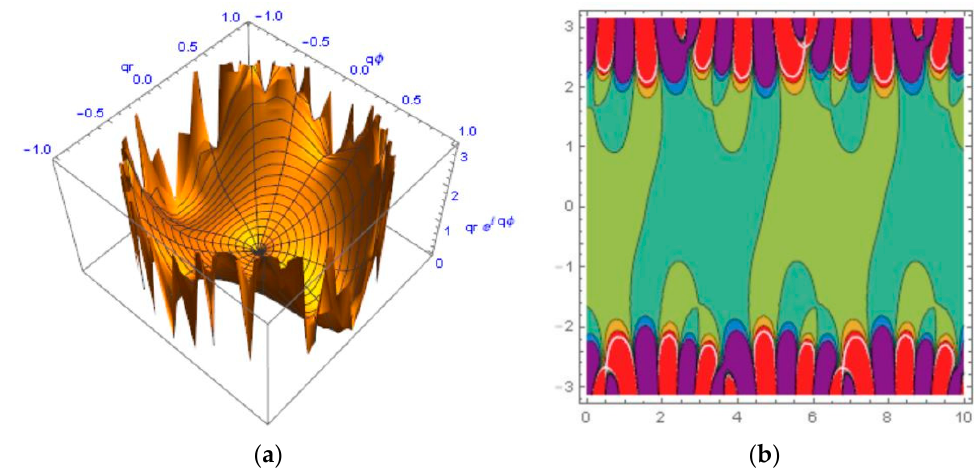
Figure 2. ( a ) 3D plot of iq qre φ with nome q ; ( b ) 2D plot of real part of an elliptic module function q = e i πτ . Symmetries in ( a ) display a 3D plot and in ( b ) a 2D plot of an elliptic module function. The j -function is an elliptic module function such as an elliptic theta function. A sample elliptic theta plot is shown in this Figure. Such functions are expressed in terms of a nome q = e i πτ . Then, for a complex number z , Jacobi theta functions are defined in terms the nome q , e.g., ϑ 1 ( z , q ) ≡